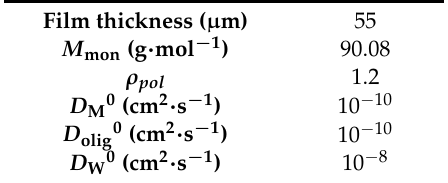
Table 2. Model input parameters.